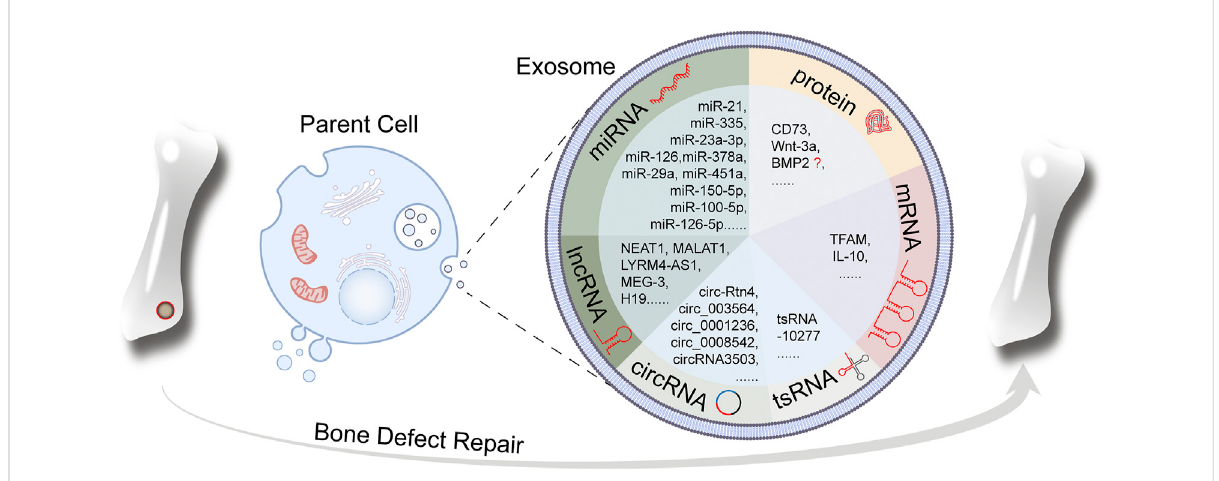
FIGURE 1 Schematic of exosomal cargos (miRNA, lncRNA, circRNA, tsRNA, mRNA and protein) with the function of promoting bone